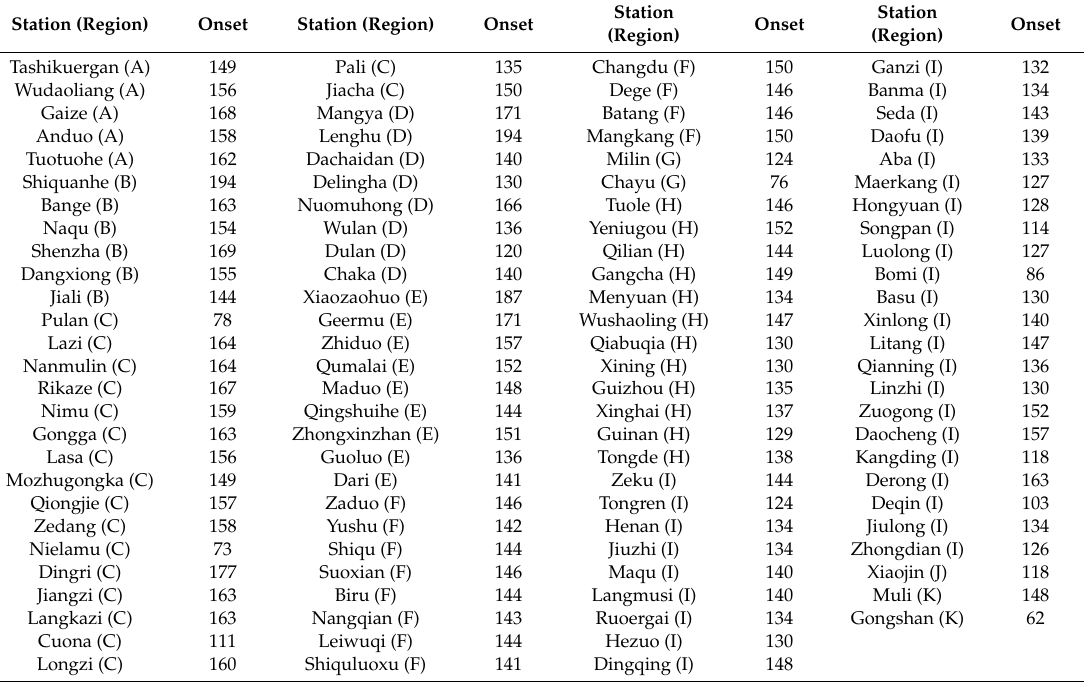
Table 1. List of meteorological stations in the region and the annual average rainy season onset (Julian Day).